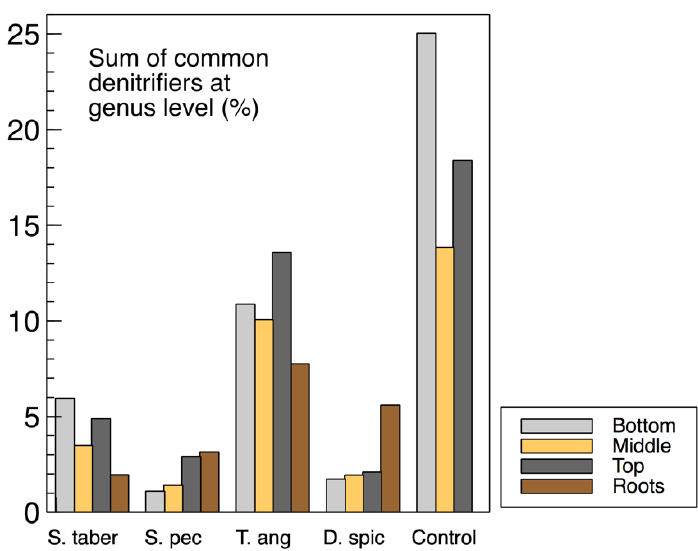
Figure 9. Abundance of denitrifiers in the wood-chip and root samples.